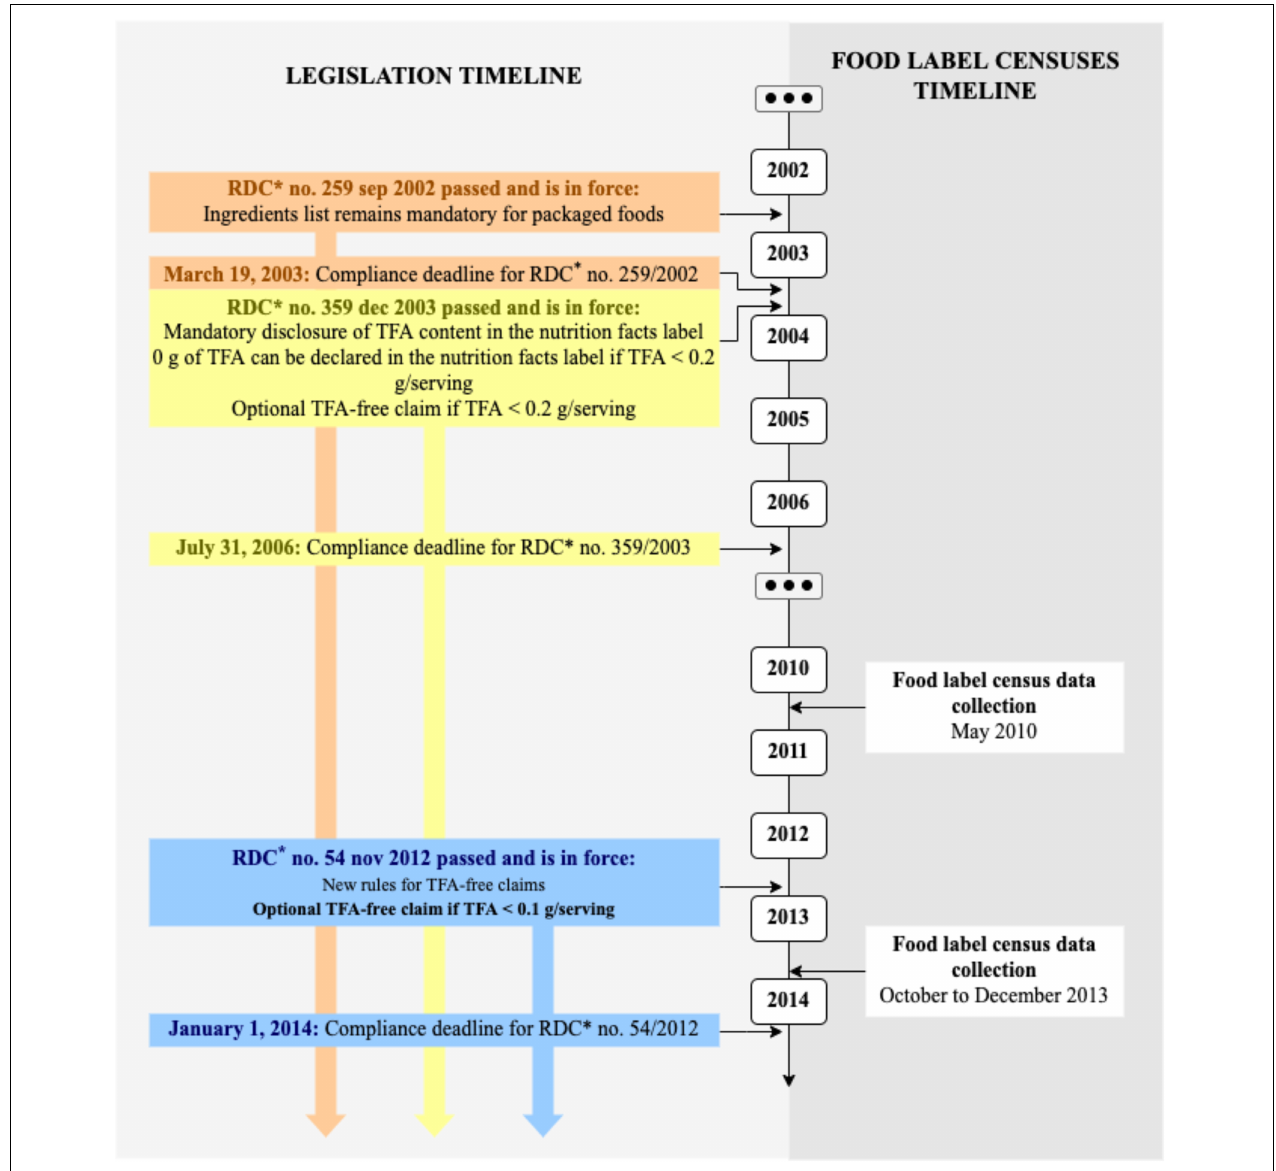
FIGURE 1 | Timeline (2002–2014) of legislation on trans-fat acid (TFA) food labeling and food label censuses. ∗ RDC, Resolution of the Collegiate Board of Directors of the Brazilian Health Regulatory Agency.